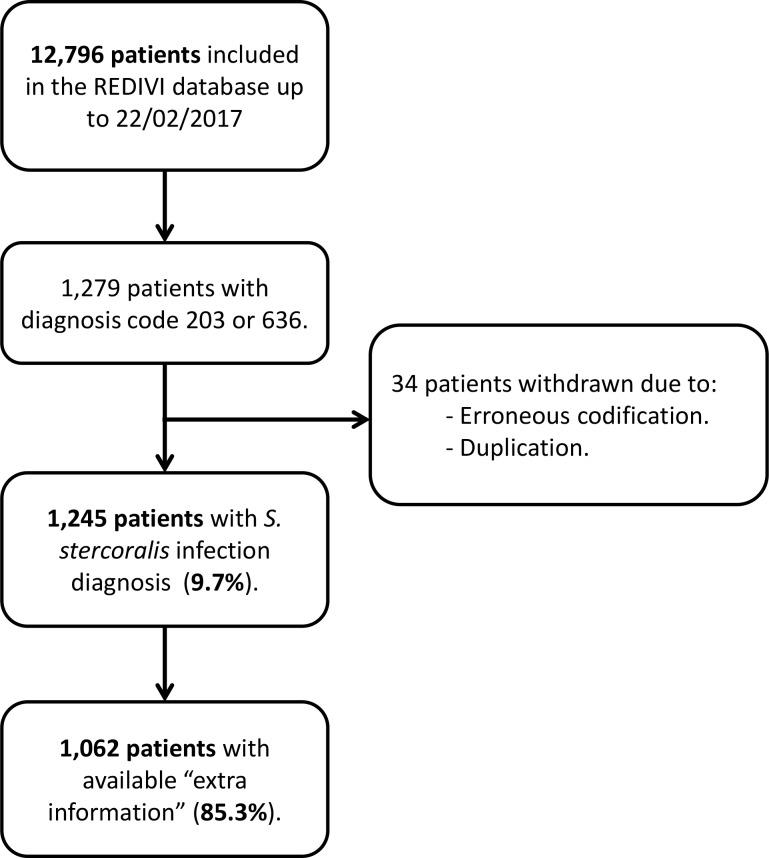
Flow diagram of patients.